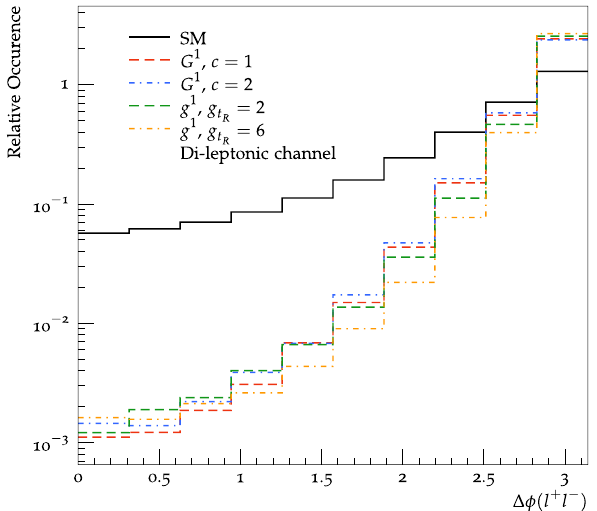
Fig. 6 Distribution of (cid:9)φ( l + l − ) for the considered scenarios for invariantmasses m ( t ¯ t ) > 2TeV.Thesignalmodelsalluse m ( G 1 / g 1 ) = 3 TeV